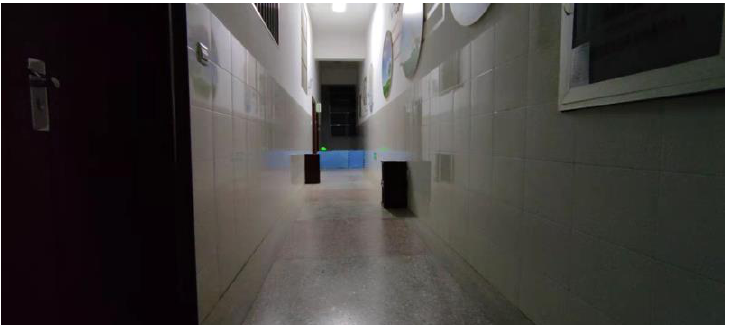
Figure 7. Long corridor used for test.